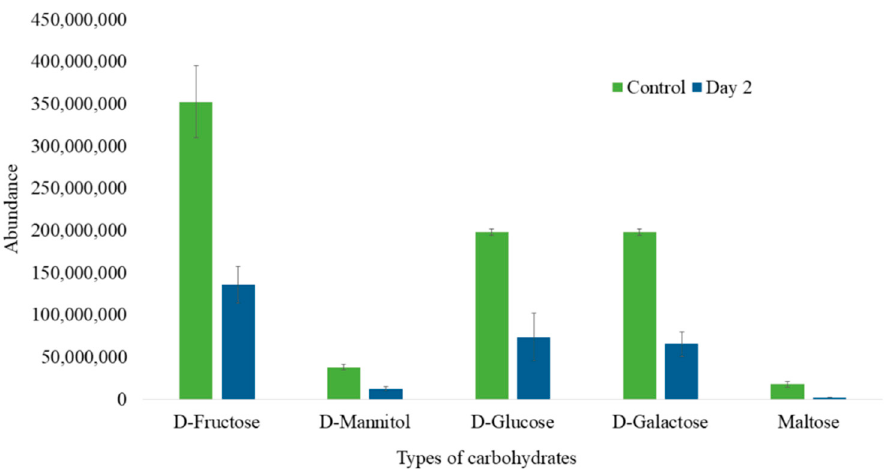
Figure 3. Metabolites belonging to the class of carbohydrate, as analyzed by GC-MS. Green bars represent the levels of the unfermented BSG samples, whereas the blue bars represent the levels of the fermented BSG samples.